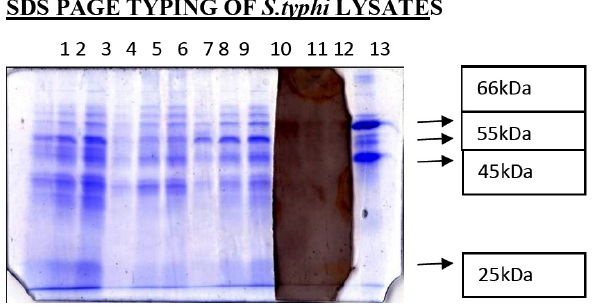
Fig. 2. Ponsseau blue staining: Lane 1: S.typhi standard strain - 5µl.Lane 2: S.typhi standard strain- 10µl.Lane 3: S.typhi standard strain- 15µl.Lane 4: Negative control strain - 5µl.Lane 5: Negative control strain - 10µl.Lane 6: Negative control strain - 15µl.Lane 7: S.typhi strain- 5µl.Lane 8: S.typhi strain- 10µl.Lane 9: S.typhi strain- 15µl. Lane10 : LPS - 15µg. Silver staining :Lane 11 : LPS – 10µg.Lane 12 : LPS – 5µg. Lane 13: Molecular weight marker – (BSA- 5µg, OVA- 5µg, IgG- 5µg)